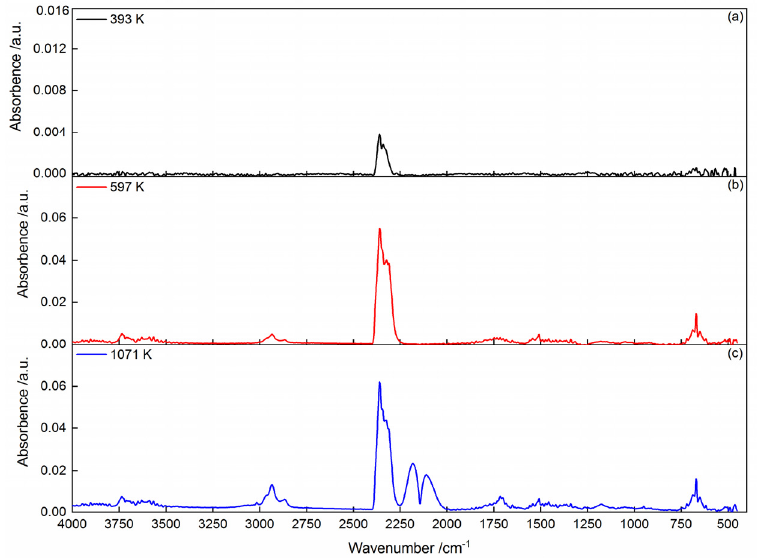
Figure 5. FTIR spectra of volatile gas products from the cold-rolling oily sludge pyrolysis at different temperatures: ( a ) 393 K; ( b ) 597 K; ( c ) 1071 K. Table 5. IR absorption bands for the volatile gas products from cold-rolling oil sludge pyrolysis and the corresponding vibration types of the species.